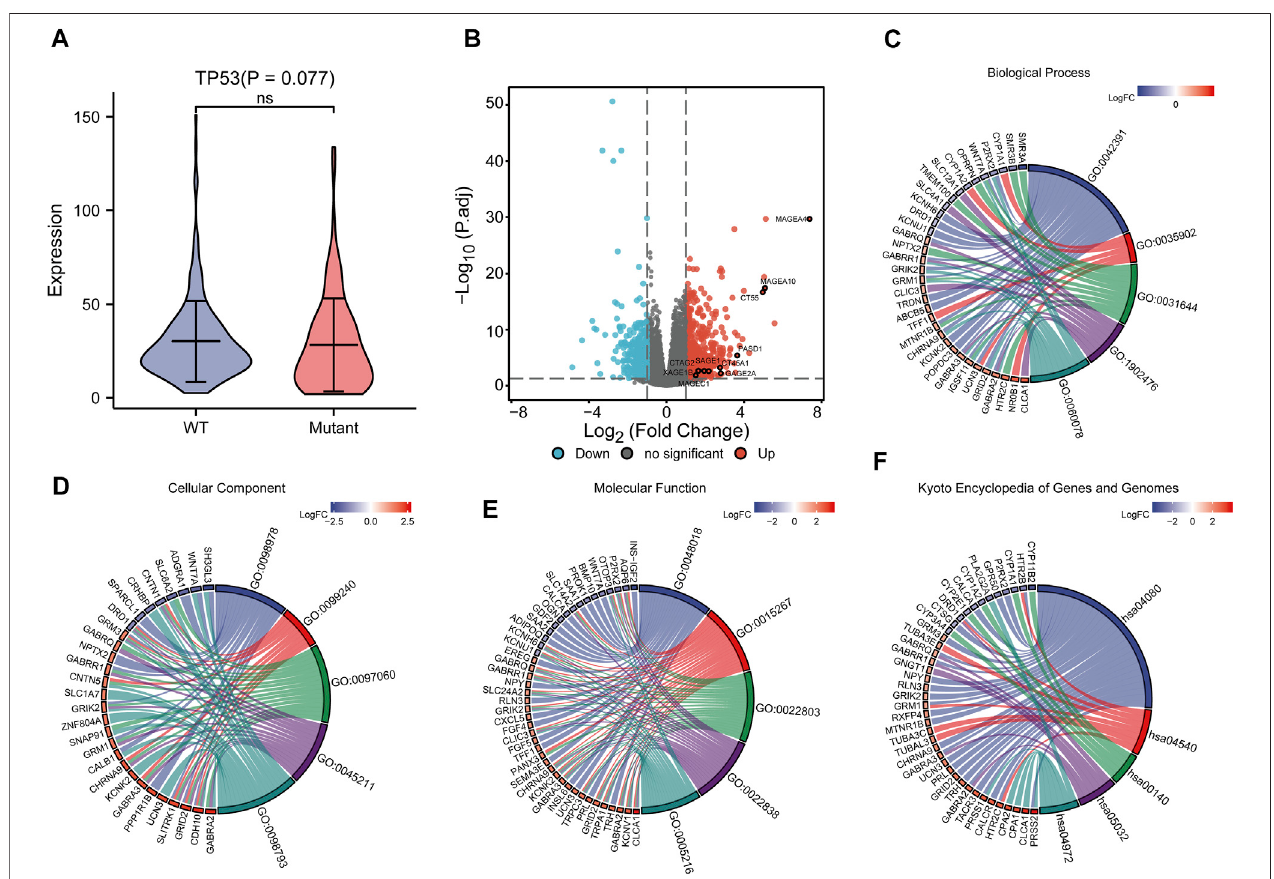
FIGURE4| DifferentialexpressionandfunctionalenrichmentanalysisbasedonTP53genemutation. (A) :Therewasnosigni fi cantdifferenceintheexpressionlevel betweenTP53mutationandnon-mutation( p =0.077). (B) :VolcanomapofdifferentiallyexpressedgenesbetweenTP53mutantandnon-mutantgroups.GOanalysisof differentially expressed genes, (C) : Biological processes, (D) : cellular component, (E) : molecular function. (F) : KEGG pathway enrichment